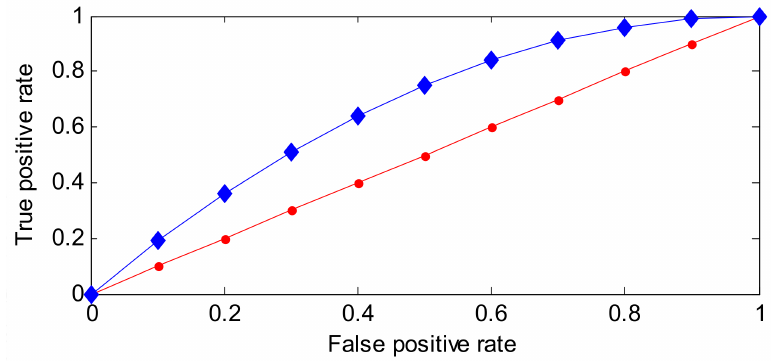
Figure 5. One example of a receiver operating characteristic (ROC)